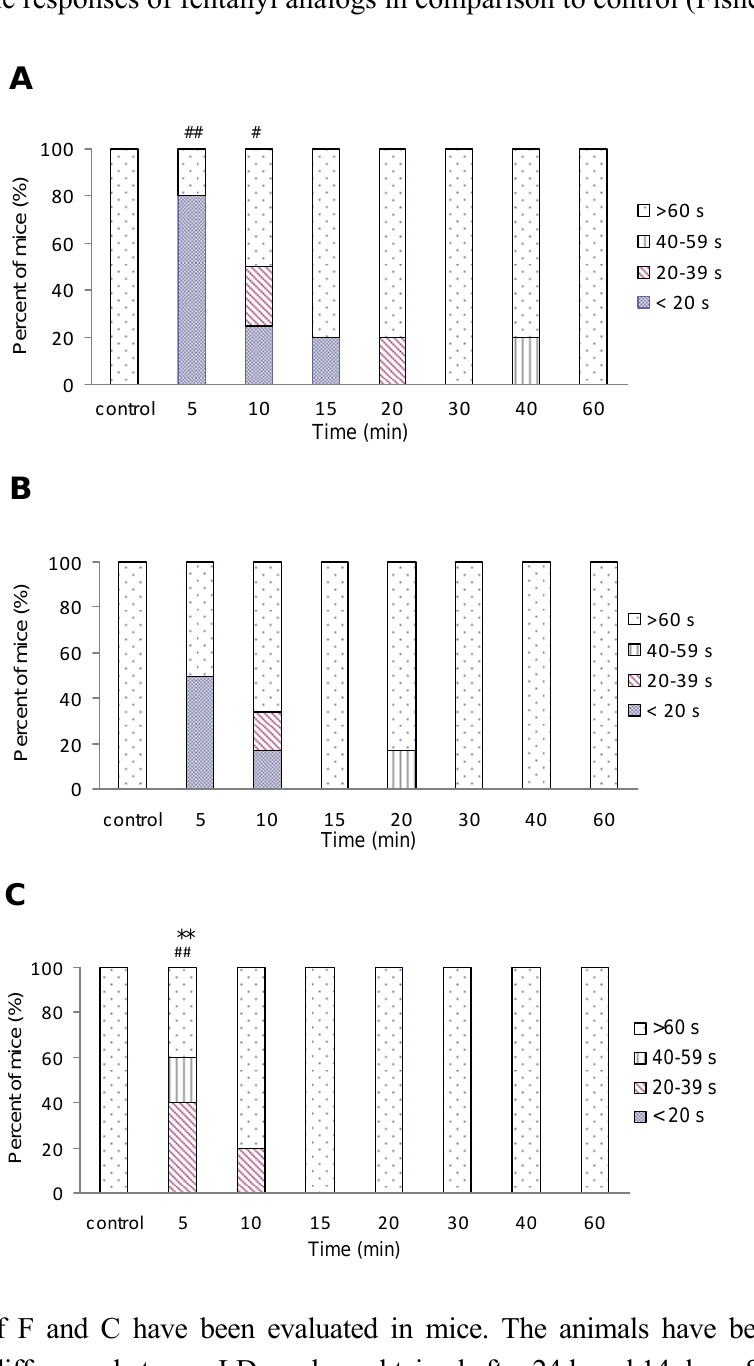
Figure 4. Time course of the effects of A) fentanyl, B) (±) cis -3-carbomethoxyfentanyl and C) (±) trans -3-carbomethoxyfentanyl on motor performance of mice. The incidence of motor impairment is plotted as a function of time after i.p. injection of equi-effective doses i.e. 4xED for antinociception of each drug. Each drug was tested by using 6–10 rats. 50 Each point represents the percentage of rats that respond according to criterion: >20, 20–39, 40–59 and >60 s spent on rotarod. * P < 0.05 and ** P < 0.01 (Mann-Whitney test) indicate a significant difference of the responses of (±) cis- or trans -3-carbomethoxy- fentanyl in comparison to fentanyl. # P < 0.05 and ## P < 0.01 indicate a significant difference of the responses of fentanyl analogs in comparison to control (Fisher’s